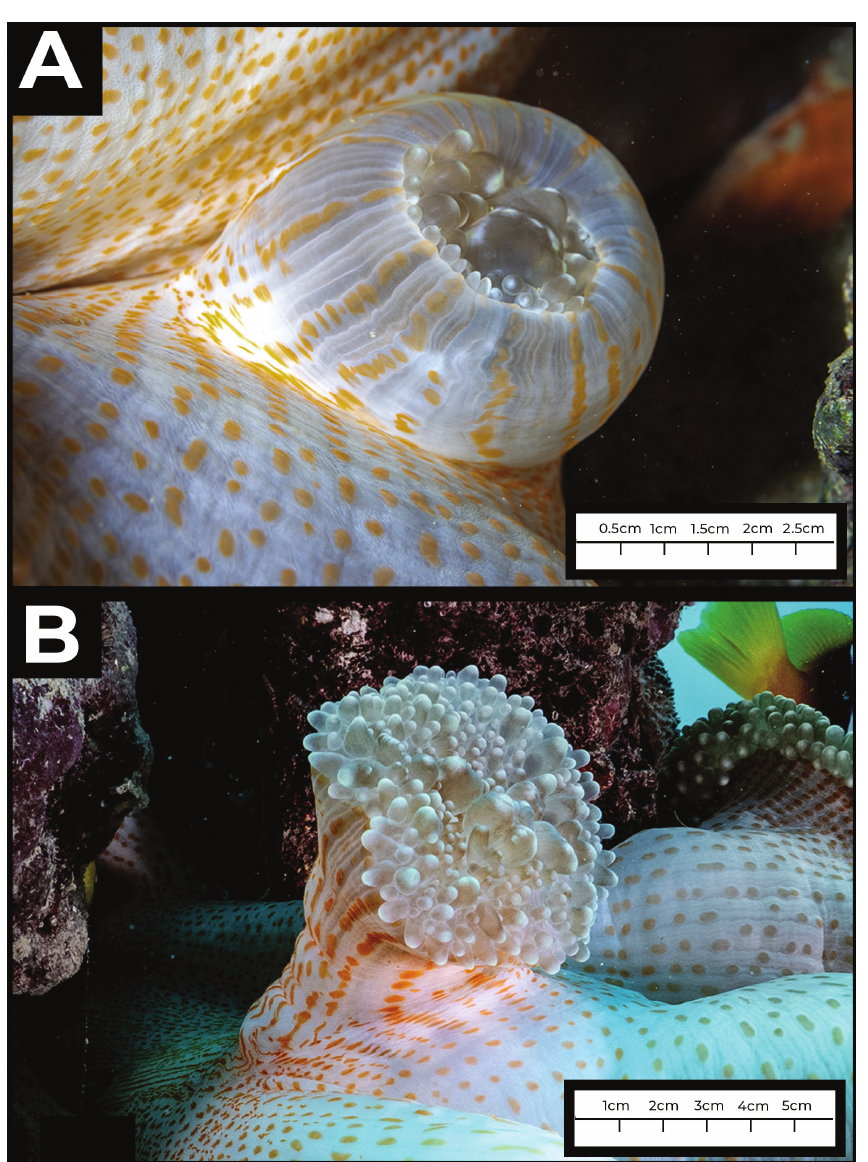
Figure 3. In situ macro images of new asexual bud on Stichodactyla mertensii near Thuwal, Saudi Arabi at two time points A initial observation, December 2021; bud oral disc diameter ~2 cm B second observa- tion, February 2022; bud oral disc diameter ~5